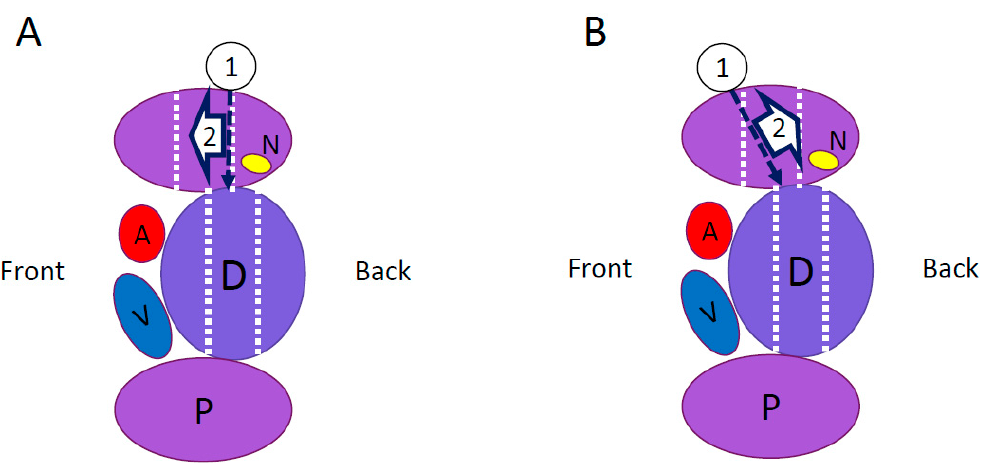
Figure 2. ( A ) In group X, after exposing the lateral aspect of the psoas muscle, the position of the intervertebral disc was confirmed by using fluoroscopy. To reach the center of the intervertebral disc, the posterior third of the psoas muscle was pulled forward with a shim. ( B ) In group A, a different method was used for approaching the psoas muscle and retracting its anterior third. Under fluoroscopic guidance, the anterior third of the intervertebral disc was reached, and the psoas muscle was pulled posteriorly. ○ 1 : Entry point of the psoas muscle, ○ 2 : direction of retractor opening, P: psoas muscle, D: intervertebral disc, A: aorta, V: vein, and N: nerve.